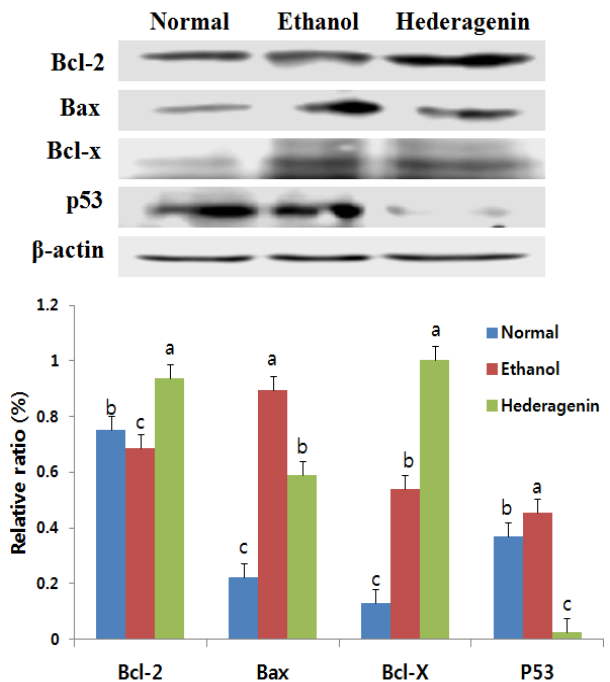
Figure 5. Effects of hederagenin on apoptotic signaling cascades in ethanol-treated hepatocytes. Extracts of the liver proteins from the different groups were subjected to Western blotting. Expression levels of cytoplasmic Bcl-2, Bax, Bcl-X, and p53 are shown. Results are expressed as the means ± SD. Significant differences ( p < 0.05) are represented using different